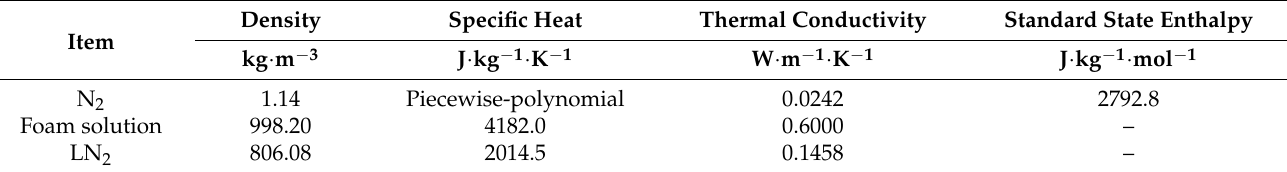
Table 2. The thermal properties of materials